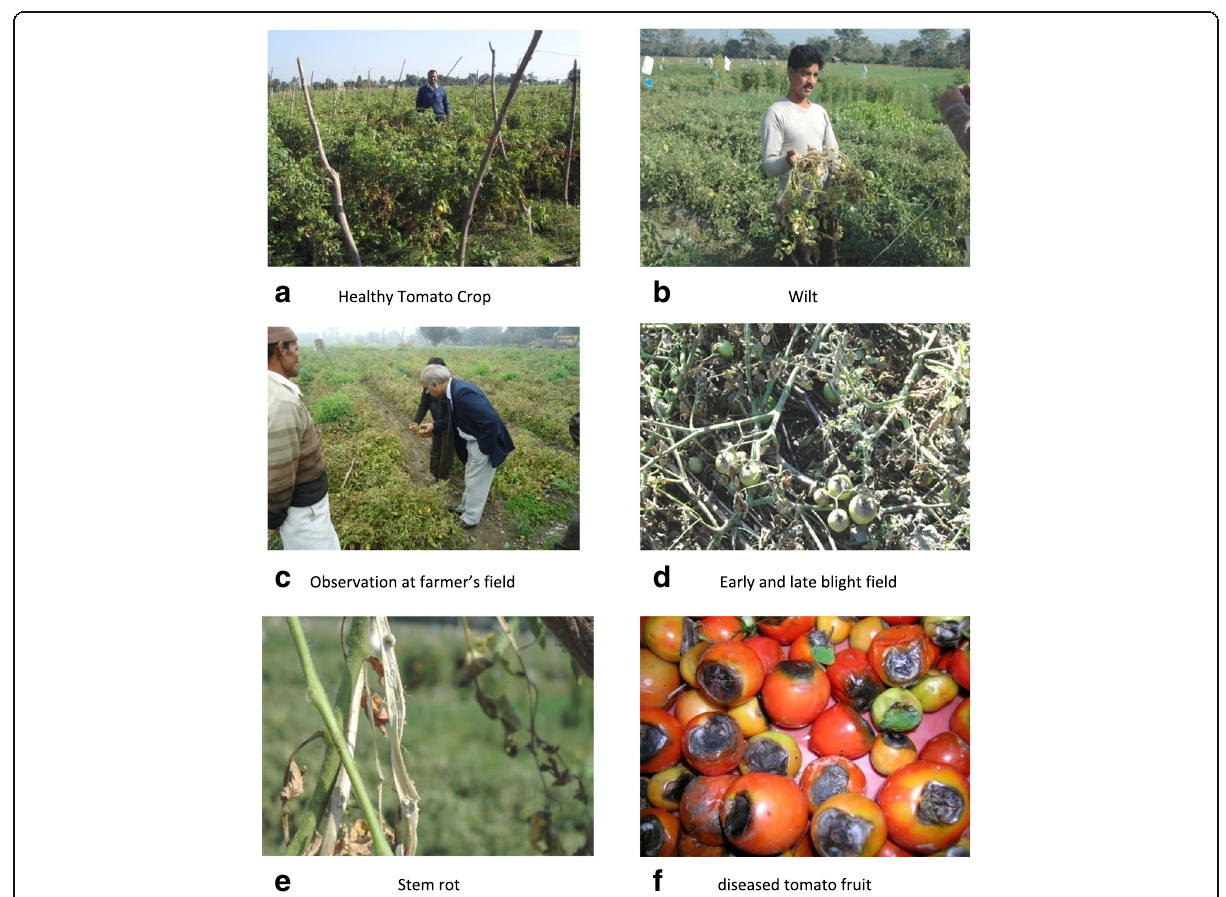
Fig. 1 In Golapar area of district Nainital, Uttarakhand, where tomato has since long been taken as a cash crop, cost of cultivation has risen dramatically in view of the increased impact of above diseases and pests. Together with crop losses and increased cost of cultivation, farm gate price of the crop has increased resulting in diminishing margins. To counter the situation, farmers resort to indiscriminate use of pesticide